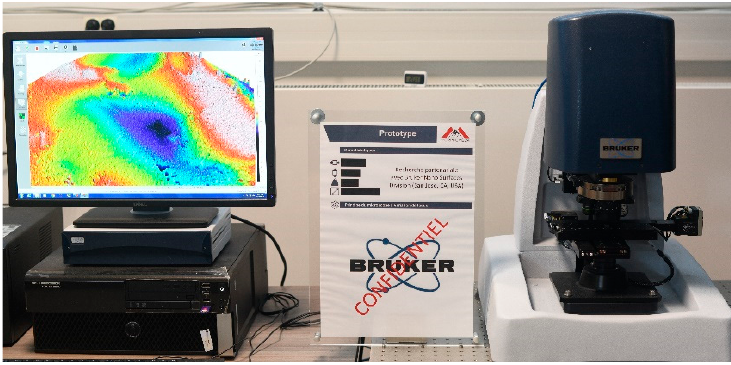
Figure 4. Image of focus variation microscopy (Contour LSK) developed.